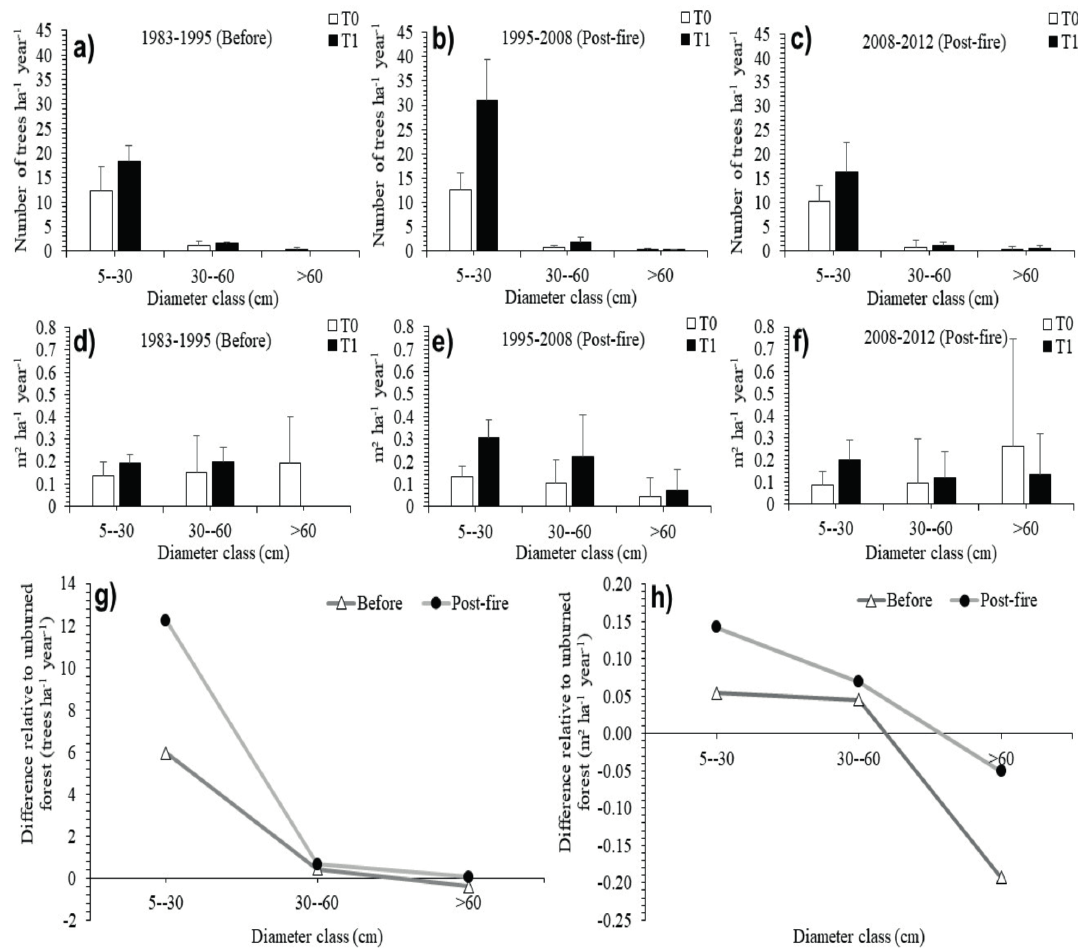
Figure 4 - Annual Mortality (trees ha -1 year -1 ) by diameter classes (cm), from 1983 to 1995 ( a ), 1995 to 2008 ( b ), 2008 to 2012 ( c ) and losses in basal area (m² ha -1 year -1 ), caused by tree mortality from 1983 to 1995 ( d ), 1995 to 2008 ( e ) and 2008 to 2012 ( f ), for burnt (T1) and unburned (T0) plots, and the difference between the mortality rates ( g ) and losses in basal area ( h ), by diameter class, recorded for the forest affected by fire in comparison to the forest not affected, before and after fire, in an dense ombrophylous forest, with no history of logging, in the Floresta Nacional do Tapajós, Pará State,